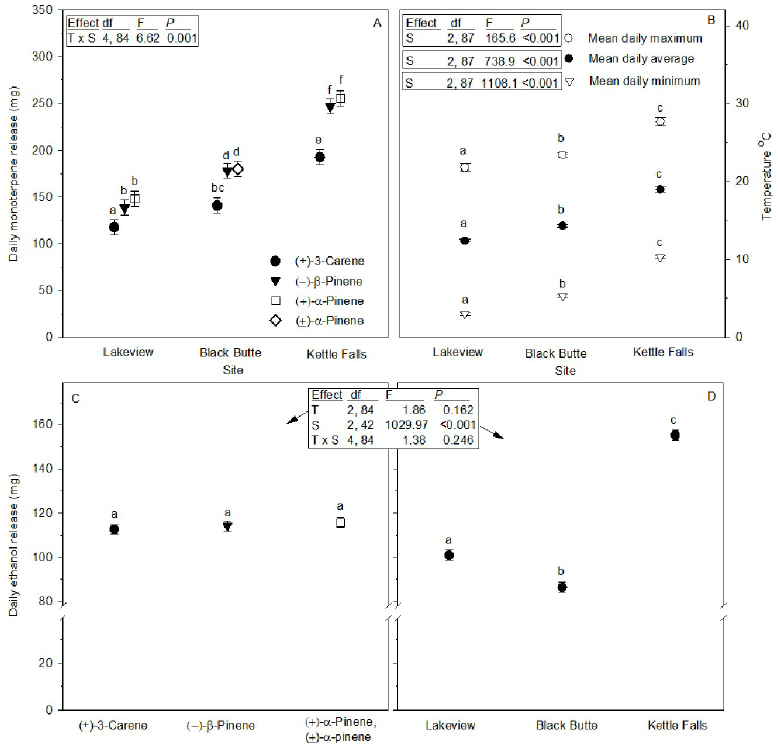
Fig 4. Field release rates and temperatures of monoterpene and ethanol lures (means ± 95% CIs). (A) Daily monoterpene release rates at each study site ( n = 15). (+)- α -pinene, ( ± )- α -pinene,or (–)- β -pinene had higher releases because three bottles of each were needed to obtain similar release by one bottle of (+)-3-carene based on laboratory results, Fig 5C and 5D. (B) Daily maximum, minimum and average temperatures in lure mixing jars at each site. (C) Daily ethanol release rates for each monoterpene lure type across all three study sites ( n = 45). (D) Daily ethanol release rates within each site across all monoterpene lures ( n = 45). Symbols with different letters in A, C, and D are statistically different at P � 0.05 for all comparisons, and at P � 0.001 for all B comparisons. Inserted boxes show ANOVA table results for each statistical analysis with effects abbreviated; T = terpene, S = site. Note Y-axis breaks in graph C and